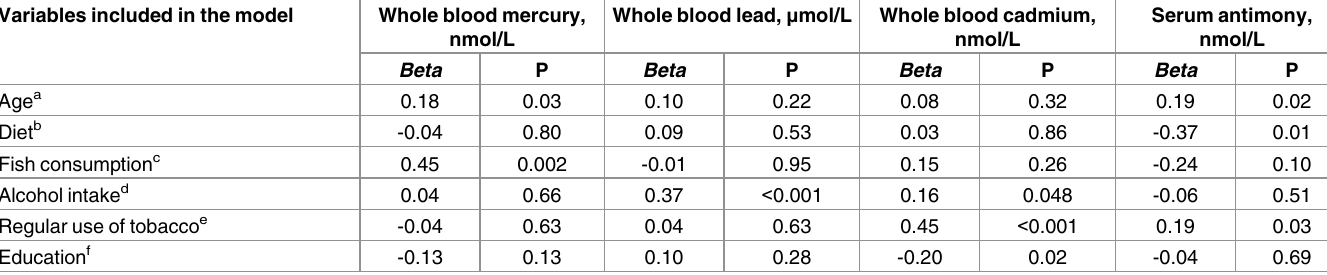
Table 3. Determinants of toxic trace elements levels in healthy never-pregnant women (n = 158) by multiple linear regression. Variables included in the model